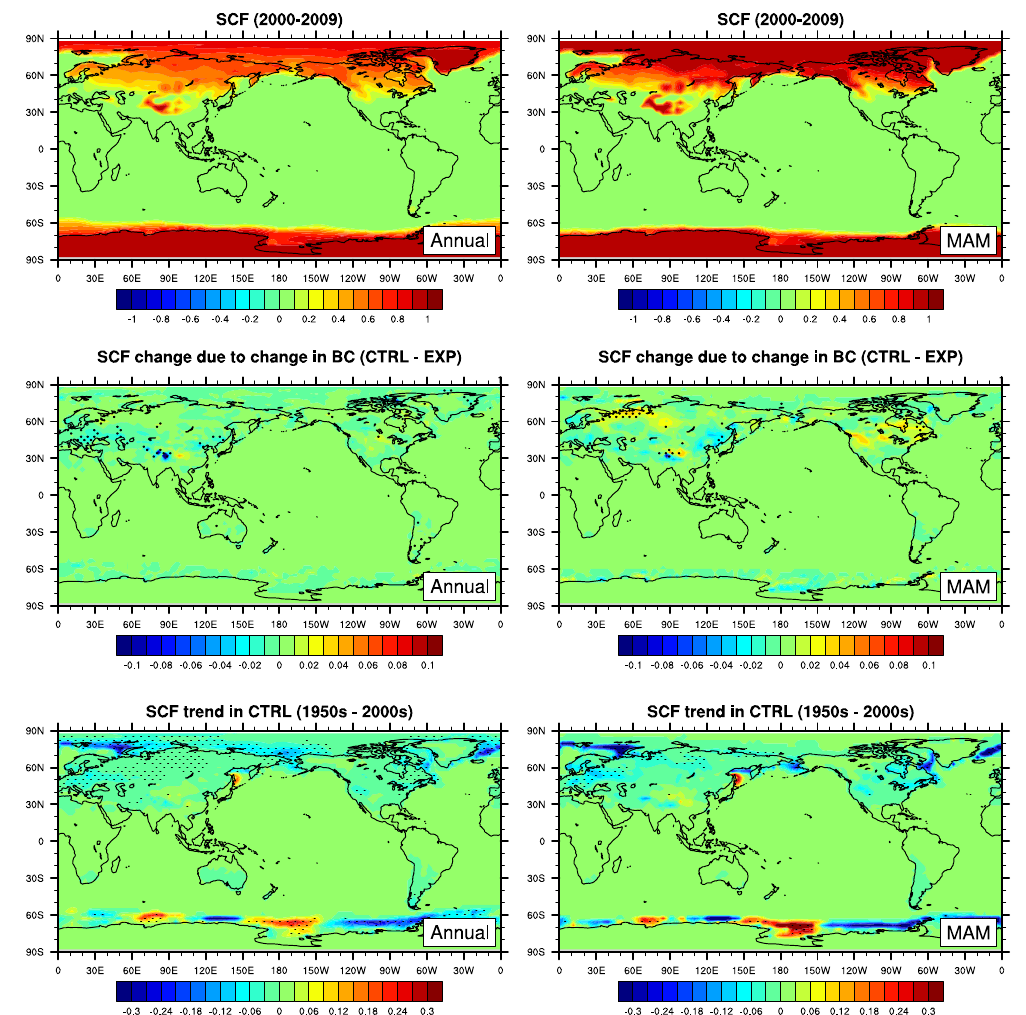
Figure 8. Annual mean (top left) and spring mean (top right) snow cover fraction during 2000–2009, annual mean (middle left) and spring mean (middle right) snow cover fraction changes due to BC in snow from the 1950s to 2000s, and annual mean (bottom left) and spring mean (bottom right) snow cover fraction changes due to all forcing from the 1950s to 2000s. Hatching indicates regions where the results are statistically significant ( p = 0 .